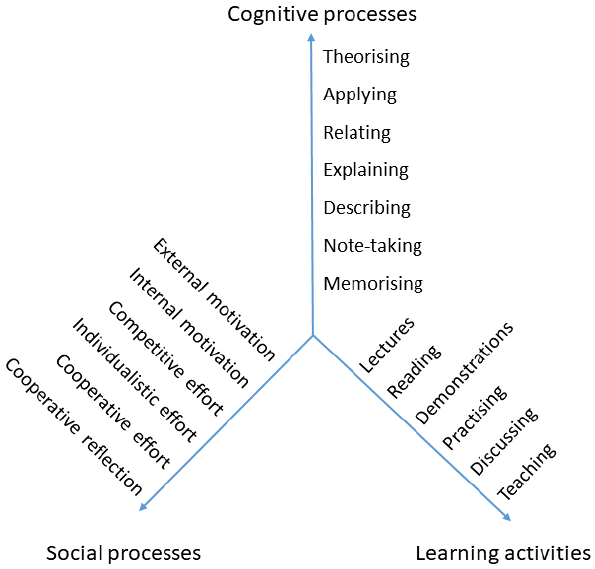
Figure 1: Three dimensions of